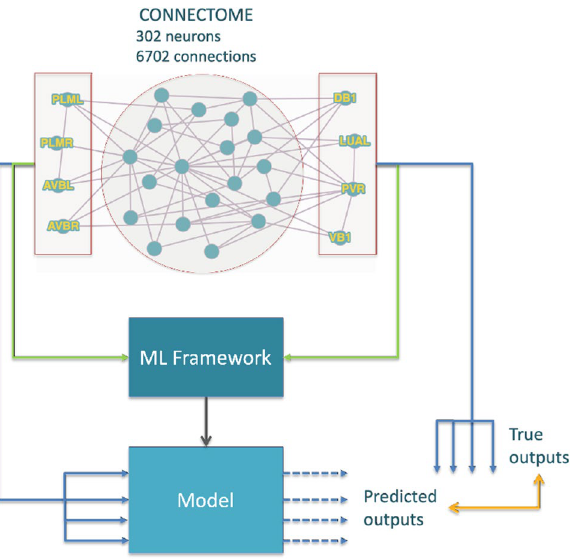
Figure 2. Modelling methodology. The learning machine is trained with input–output data reproducing selected behaviours and then tested against inputs it has not seen